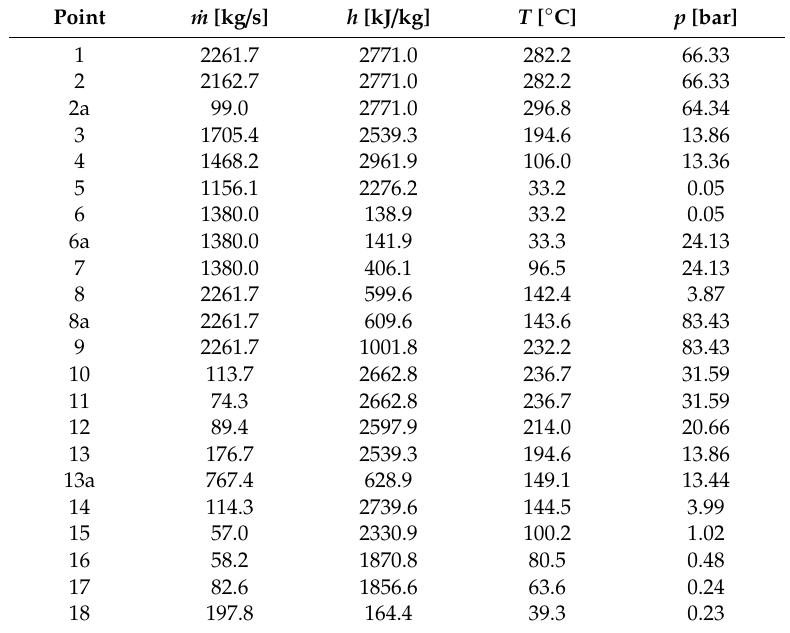
Table 1. APR1400 Secondary cycle Maximum Guaranteed Rate (MGR) operation